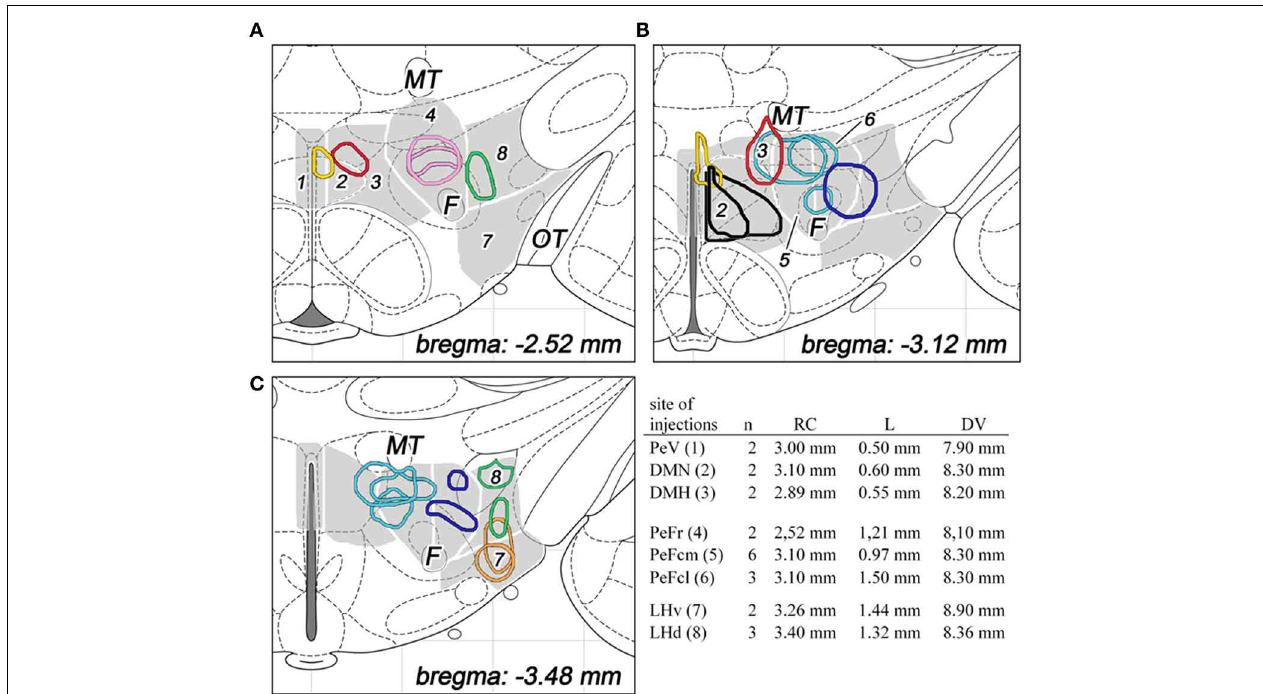
FIGURE 2 | The sites and extensions of BDA injections in various parts of the dorsolateral hypothalamus are shown on coronal sections of the hypothalamus, based on drawings from the atlas of Paxinos and Watson (2007). The different regions of the dorsolateral hypothalamus are numbered and indicated in gray background with white line borders in three different rostrocaudal levels (A–C) . The injection sites are colored as follow: periventricular area (PeV, yellow), rostral perifornical area (PeFr, pink), caudomedial perifornical area (PeFcm, light blue), caudolateral perifornical area (PeFcl, dark blue), dorsomedial